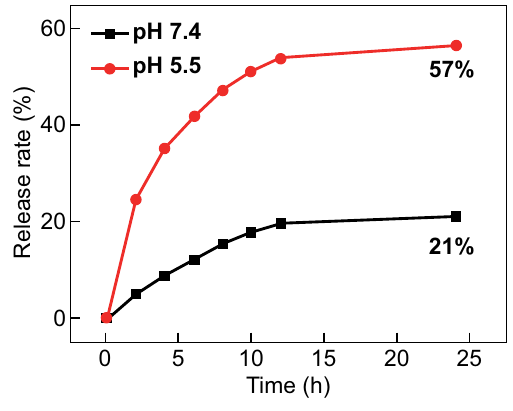
Fig. 3 In vitro DOX release curves of DOX-loaded MSNs–CDs in phosphate buffers (10 mM) of pH 7.4 and 5.5 at 37